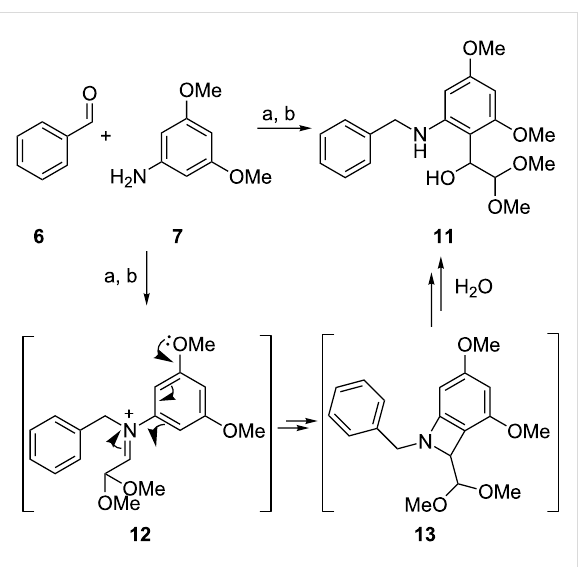
Scheme 3: Side reaction during the double alkylation of 7 and possible reaction mechanism for the formation of 11 . Conditions: